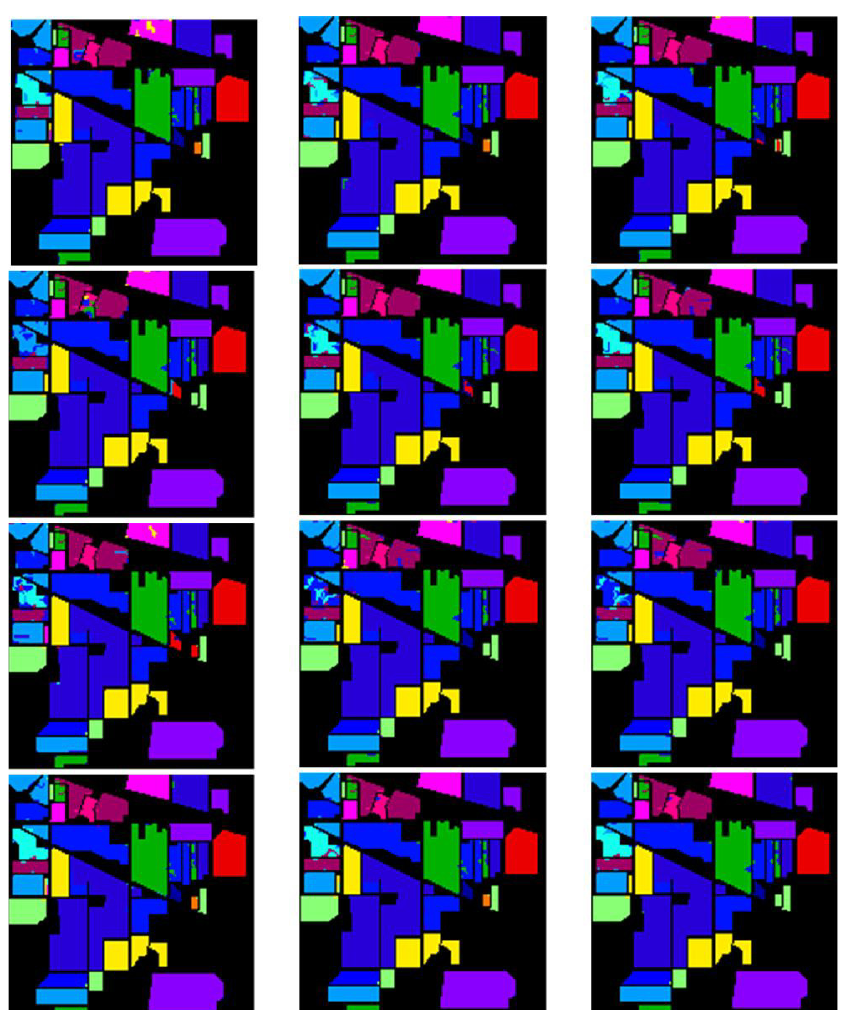
Figure 8. The classification maps of baselines and SALP over four classifiers on the Indian Pines dataset when ρ = 0.1. From the top row down to the last row: NN, SVM, RF, and ELM, from the first column to the last column: NLA, RLPA, and SALP. Please zoom in to see the